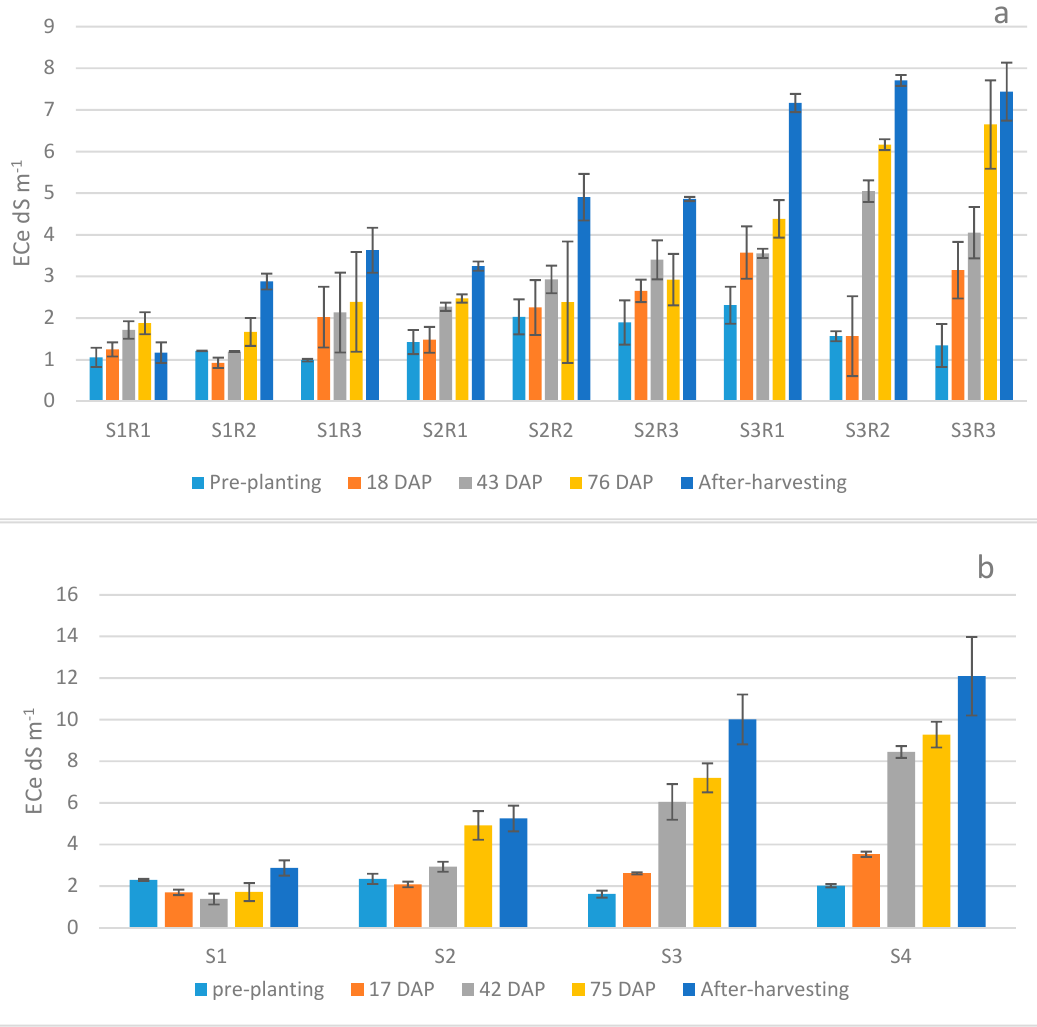
Figure 4. The mean ECe for the nine treatments of the field experiment ( a ), and the mean ECe for the four treatments in the greenhouse during the growing season ( b ). The time of ECe measurements are shown in days after planting (DAP). (Error bars represent standard errors from the mean.)